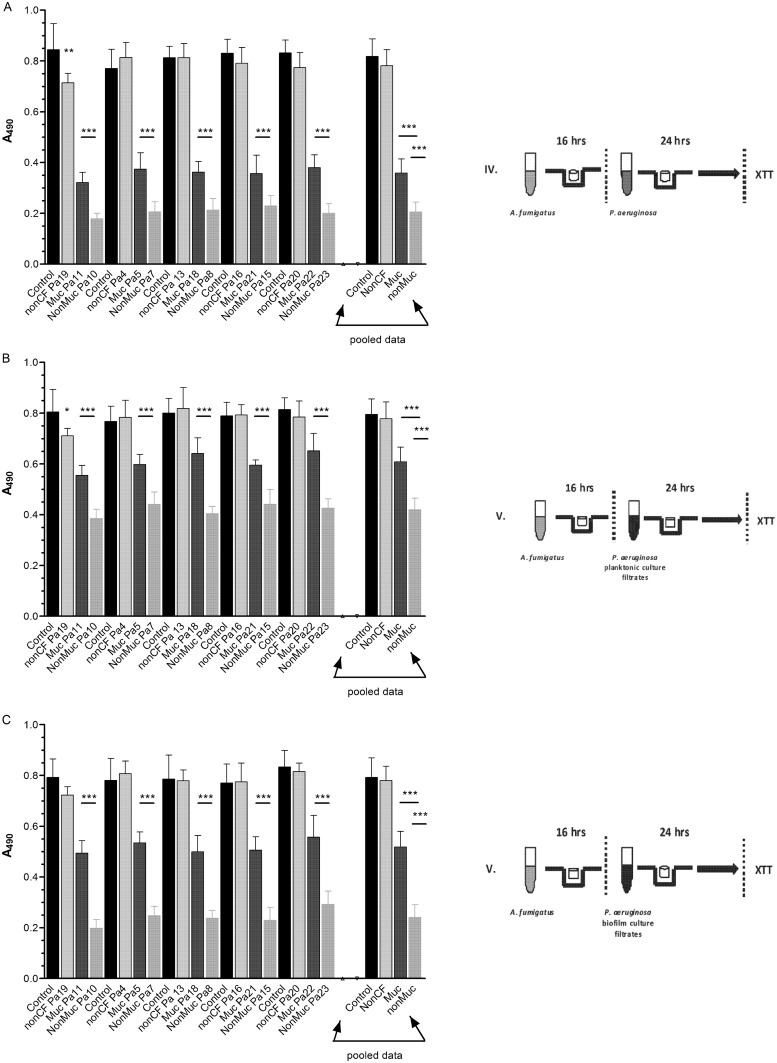

Pa inhibition of Af biofilm.The data presented show the activity of each live Pa isolate or planktonic or biofilm generated culture filtrate on preformed biofilm of Af. Individual isolate results are shown in comparison with their respective Af controls (n = 6 for each). There were five non-CF, five mucoid CF and five non-mucoid CF isolates tested; isolate designations are shown on the x-axis. The bars on the far right of each panel represent the pooled data for each isolate (n = 30). Bars represent the mean ± SD of the XTT reduction at read at 490 nm. Panel (A) Af preformed biofilms exposed to live Pa cells for 24 h. (B) Af preformed biofilms were exposed to Pa planktonic spent supernatant for 24 h. (C) Af preformed biofilms were exposed to Pa biofilm spent supernatant for 24 h. Each data point represents the XTT metabolic activity obtained spectrophotometrically at 490 nm. Assays were performed in triplicate and the results are pooled from two experiments for each Pa-Af combination. The asterisk indicates a significant P value (< 0.001) for the XTT metabolic activity compared to the positive control, using the same analytic methodology as in Fig 2. Panel (A) Individual Pa isolate comparisons showed that only a one non-CF isolate, Pa19, inhibited (P<0.01), whereas all mucoid or non-mucoid CF isolates were inhibitory (P<0.001, all comparisons). Pooled data analysis showed that both mucoid and non-mucoid CF isolates were significantly inhibitory (P<0.001, both comparisons) and that non-mucoid CF isolates were more inhibitory than non-CF or mucoid Pa isolates (P< 0.001, both comparisons). Panel (B) Planktonic spent medium from a single non-CF isolate, Pa19, was inhibitory (P<0.05), whereas all mucoid and non-mucoid CF were significantly inhibitory (P < 0.001). Pooled data analysis showed that planktonic culture filtrate from CF non-mucoid or mucoid isolates was inhibitory (P<0.001, both comparisons). Non-mucoid CF isolates were more inhibitory than mucoid CF isolates (P<0.001). Panel (C) Biofilm culture filtrate from non-CF isolates of Pa was not inhibitory, whereas the culture filtrate from each mucoid or non-mucoid CF Pa isolates was inhibitory (P< 0.001, all comparisons). Pooled data analysis showed that biofilm culture filtrate from CF non-mucoid or mucoid isolates was inhibitory (P<0.001). Non-mucoid CF isolate filtrates were more inhibitory than mucoid CF isolates (P<0.001).